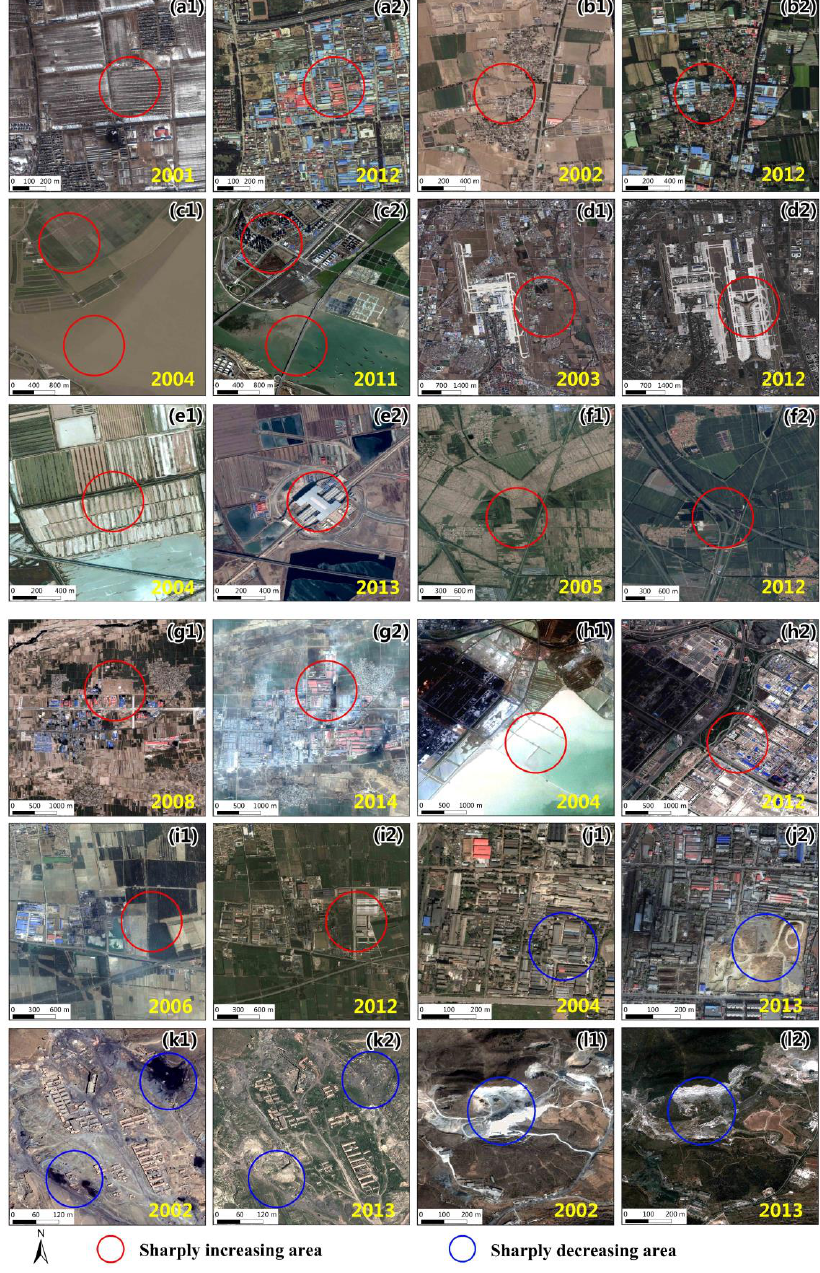
Figure 9. Validation of the typical areas where nighttime light has sharply changed. Sharply increasing areas: (a1 – c2) urban expansion; (d1 – f2) traffic development, including airports,